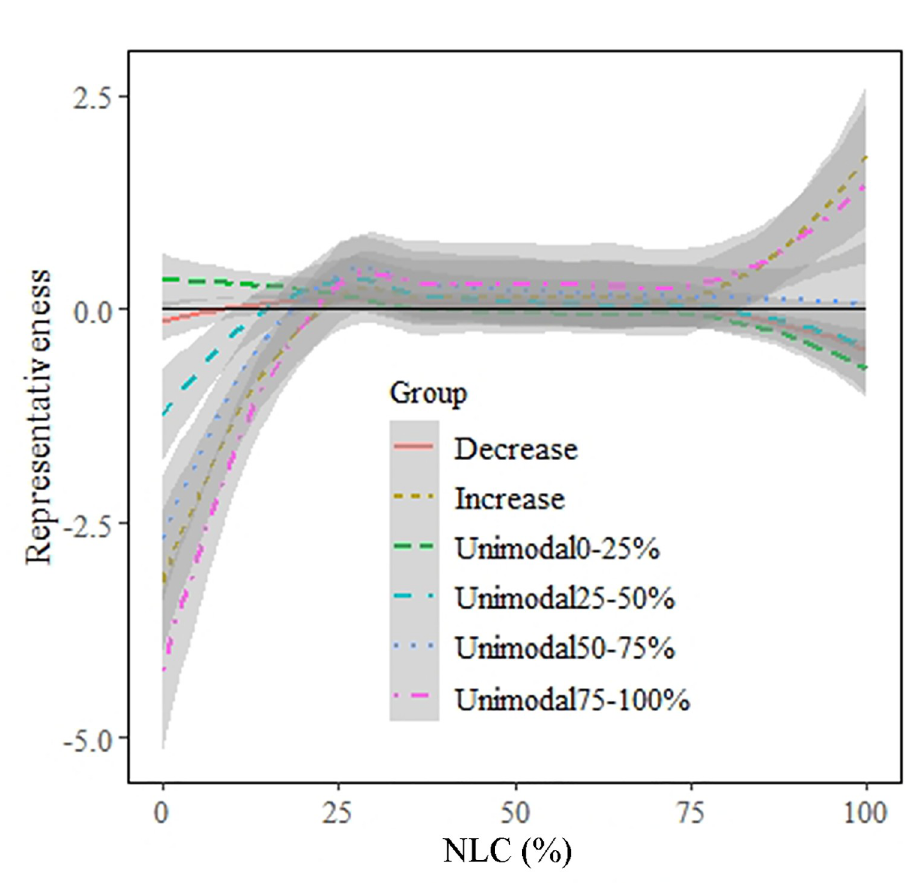
Fig 4. The representativeness, i.e. relative occurrence of a species group in relation to the NLC availability in the Netherlands. It describes the difference between the proportion of occurrence of grid cells with different NLC in the Netherlands and the relative occurrence of each species group along NLC. Species were classified into decrease, increase, preferred NLCs of 0–25% (unimodal0-25%), 25–50% (unimodal25-50%), 50–75% (unimodal50-75%) and 75–100% (unimodal75-100%), respectively. Lines represent the best-fit regressions and the grey bands represent the regression 95% confidence interval. The black horizontal line indicated 0.